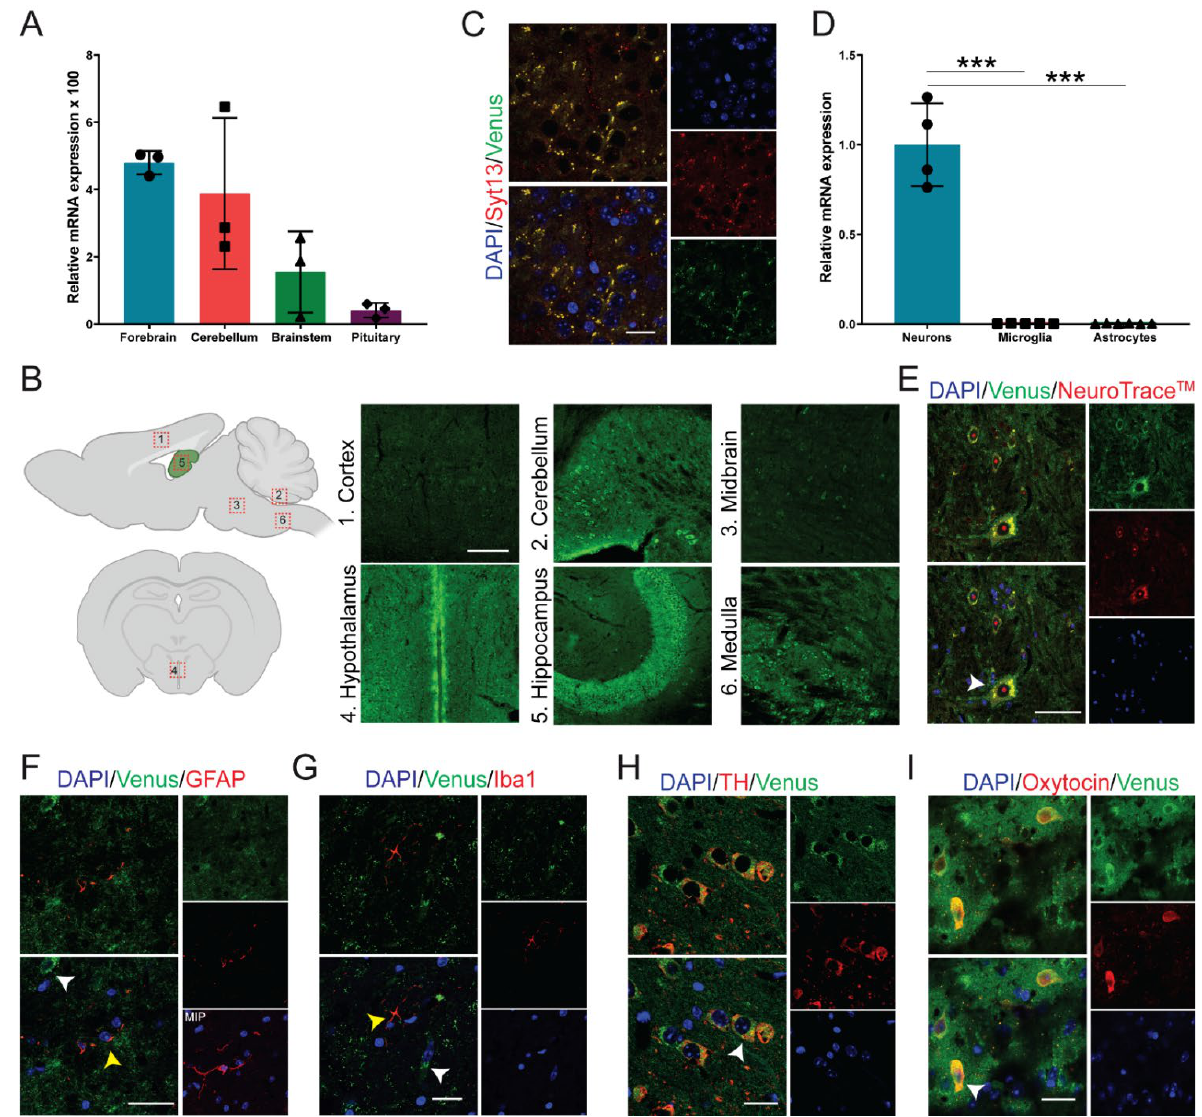
Figure 2. Syt13-VF expression in neuronal tissue. ( A ) Syt13 mRNA expression in different brain regions of adult WT male mice ( n = 3). Transcript levels were calculated according to the 2 −ΔCt method; Gapdh was used as endogenous control to normalize mRNA amount. Bars represent means 2 −ΔCt × 100 ± SD. ( B ) Scheme of brain area used for IHC, and maximum intensity projection images of Syt13-VF positive cells at different brain regions including cortex, between IV-VI cortex layers; cerebellum, an area in the proximity of the interposed cerebellar nucleus (anterior part to posterior part) and the medial (fastigial) cerebellar nucleus; midbrain, an area in the proximity of the paramedian raphe nucleus and the pontine reticular nucleus; hypothalamus (coronal orientation), anterior hypothalamus in the 3V proximity; hippocampus, CA2 region area; medulla (sagittal orientation), inferior olive area. Scale bar 100 µm. Scheme was created with BioRender.com (accessed on May 2021). ( C ) Co-staining of GFP and Syt13 in the brain cortex shows co-localization of both markers. Scale bar 20 µm. ( D ) Analysis of Syt13 mRNA expression in neuron and glia cells isolated from WT animals shows high expres- sion of Syt13 in neurons but not in microglia nor astrocytes ( n ≥ 4). ( E – G ) Immunostaining of brain sections confirm the presence of the Syt13-VF protein in neurons marked by NeuroTraceTM, but not in microglia or astrocytes marked by Iba1 and GFAP, respectively. White arrows indicate Syt13-VF and yellow arrows show glia cells. MIP, maximum intensity projection. Scale bar 20 µm. ( H , I ) Immunostaining analysis of hypothalamus regions showing colocalization of Syt13-VF with tyrosine hydroxylase (TH) and oxytocin, markers of neuroendocrine cells (white arrows). Scale bar 20 µm. (*** p < 0.001; t -test). For E–I, single confocal images were used to avoid false colocalization. Data are represented as mean ± SD.